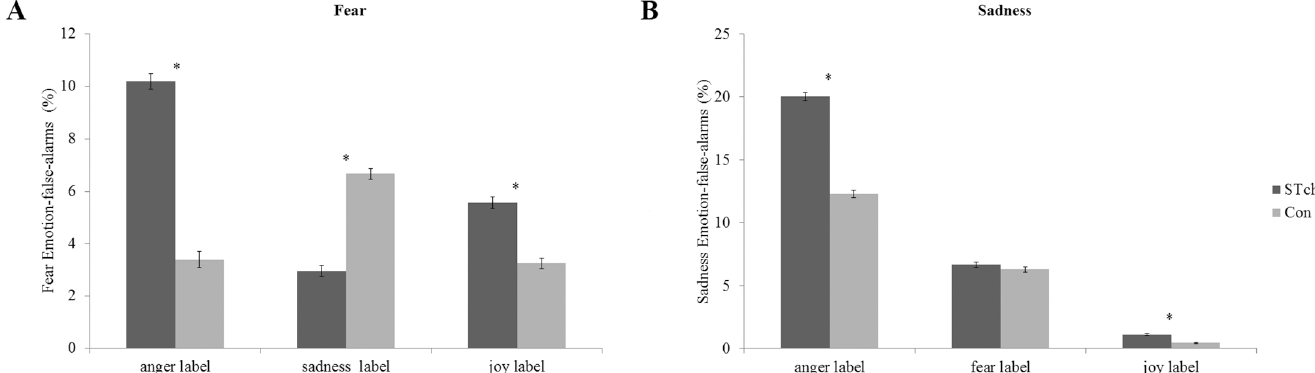
Fig 4. Fear and Sadness Emotion-false-alarms. A) Fear Emotion-false-alarms for street-children (STch) and controls (Con). * = p < 0.007. B) Sadness Emotion false alarms for street-children (STch) and controls (Con). * = p < 0.006. Both panels show only differences between groups. For differences inside each group, see text. In both panels error bars represent SE.